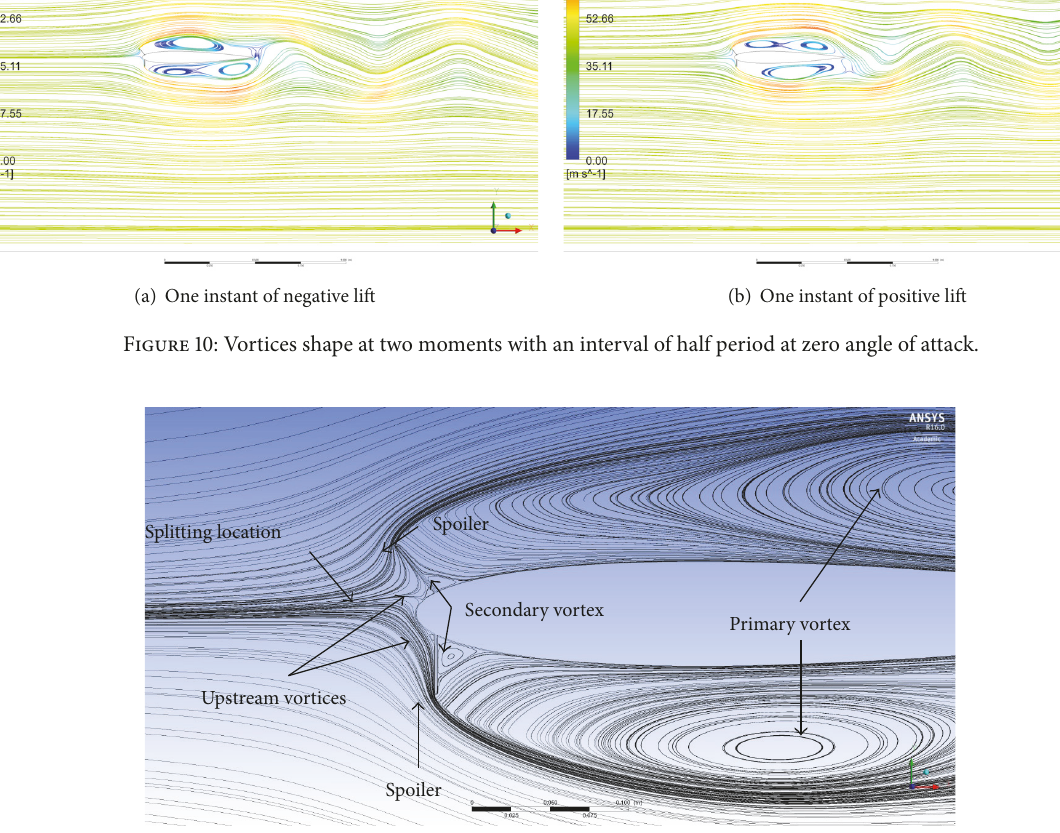
Figure 11: Flow streamlines near leading edge at 𝛼 = 0 ∘